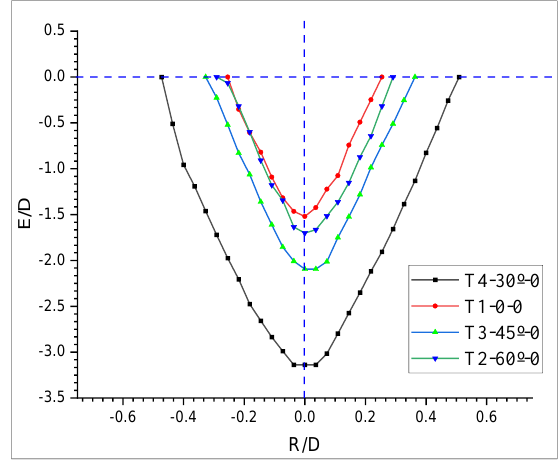
Figure 7. Effect of fan blade angles on the scour hole depth.